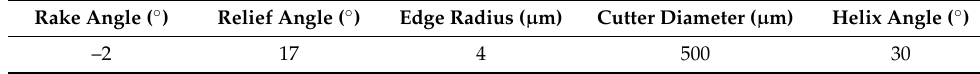
Table 4. Geometric parameters of the micro-milling